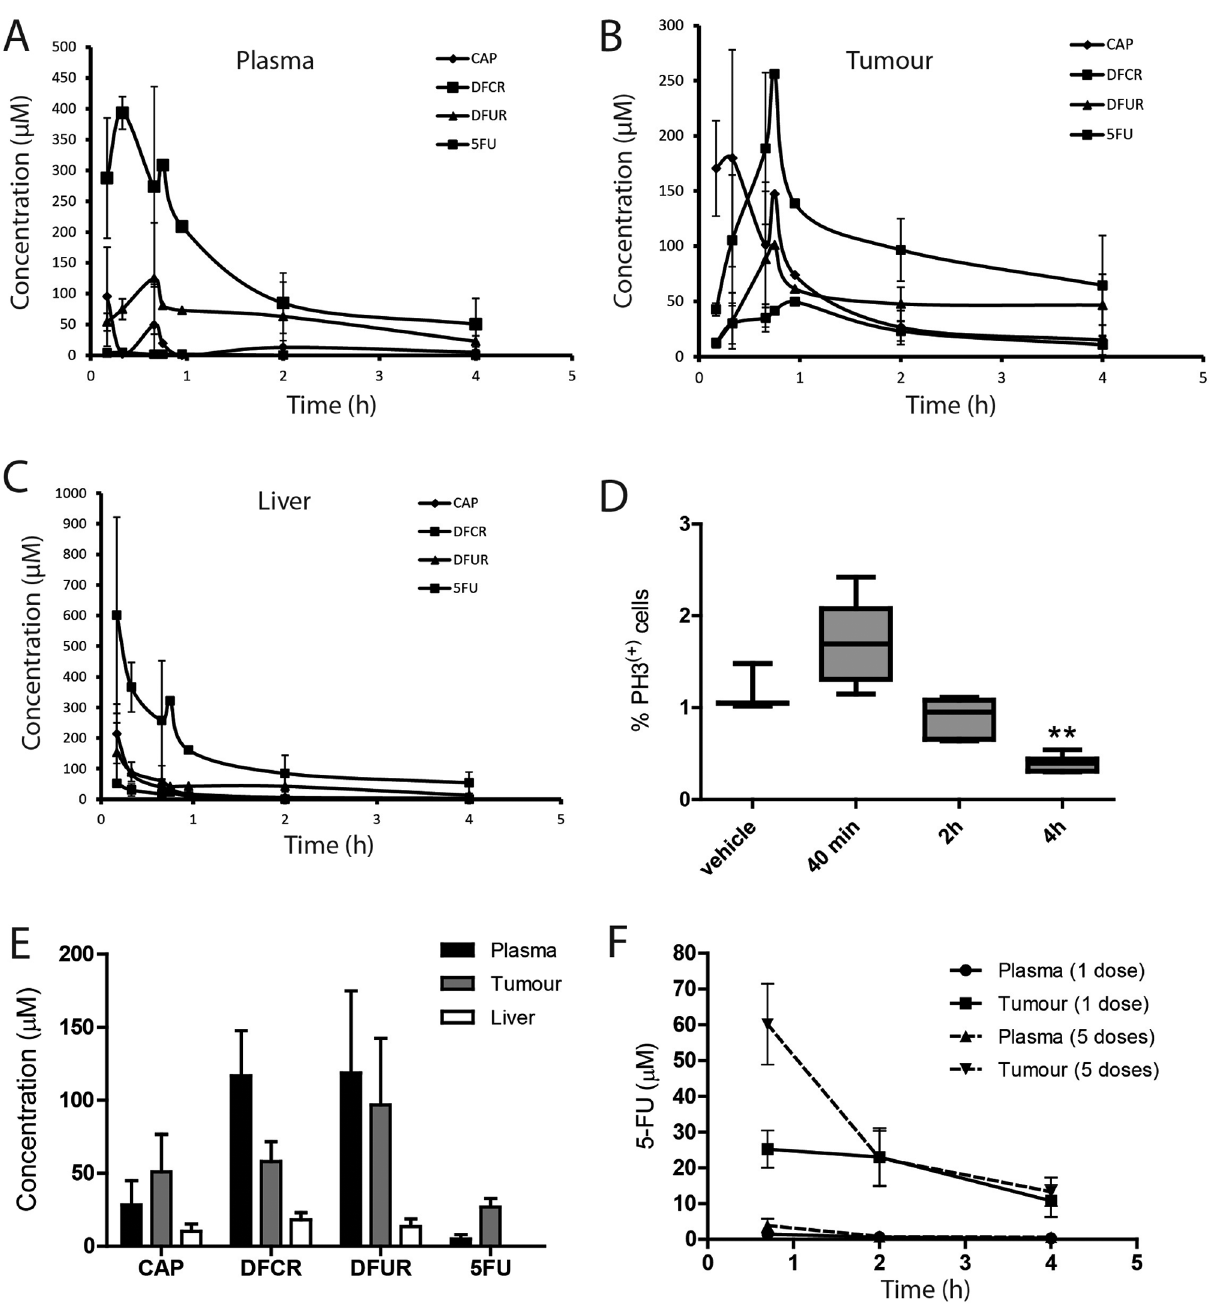
Figure 1. Pharmacokinetic and pharmacodynamics profiles of CAP in mouse tissues. Metabolite concentrations in plasma (A), K8484 allograft tumour homogenates (B) and liver homogenates (C) after a single dose of CAP at 755 mg/kg. Mean 6 SD (n=3 except for 45 min and 1 h where n=2). (D) Immunohistochemistry for phospho-histone H3 (PH3) quantified in KPC allograft tumours at different time points after a single 755 mg/kg CAP dose. Mean 6 SEM of at least three tumours (**p , 0.01). (E) Metabolite concentrations in KPC mouse tissues 2 h after the last of 7 consecutive doses of CAP at 755 mg/kg, Mean and SEM of 6 mice. (F) 5-FU concentrations 2 h after a single dose (solid line) or five consecutive doses (dashed line) of CAP (755 mg/kg) given to mice bearing K8484 allograft tumours. doi:10.1371/journal.pone.0067330.g001 PDAC tumours, 5-FU concentrations were 26.9 6 14.3 m M administered in mice bearing K8484 allografts. In this study 5-FU (Figure 1E) compared to 23.0 6 8.1 m M in KPC allograft tumours, concentrations in tumour 2 h after the fifth consecutive dose of 2 h after a single CAP dose (Figure 1B). Because of the difference CAP was 22.7 6 7.7 m M (Figure 1F), equivalent to the 5-FU in study protocol (7 doses in KPC mice versus single dose in the concentration after a single dose in allograft tumour (Figure 1B) or K8484 allografts), we also compared the data with those from an after 7 consecutive doses in KPC tumours (Figure 1E). These data suggest that multiple doses of CAP did not lead to 5-FU independent PK study performed after 5 daily doses of CAP